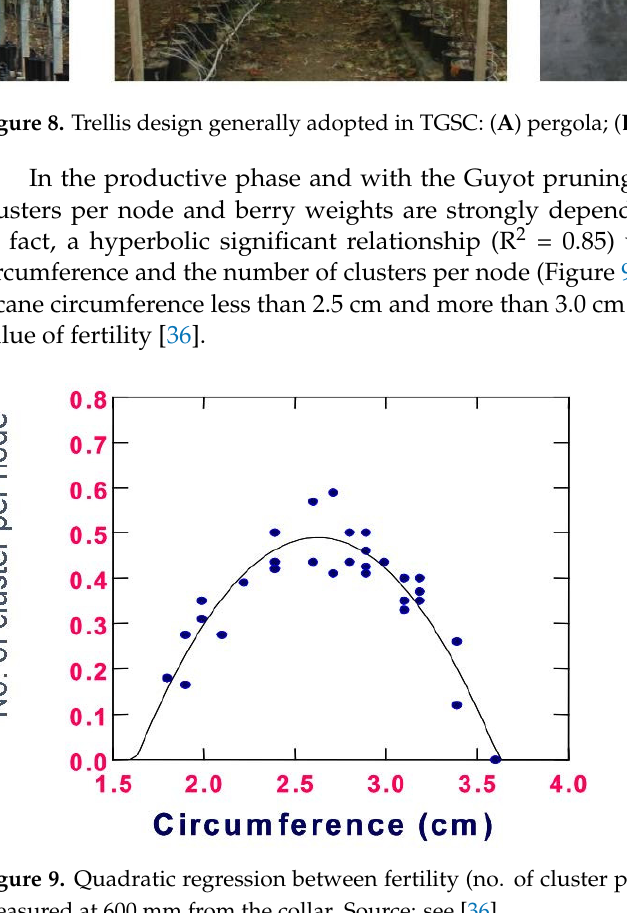
Figure 10. Operational schematic representation of the TGSC plant training and production phases.